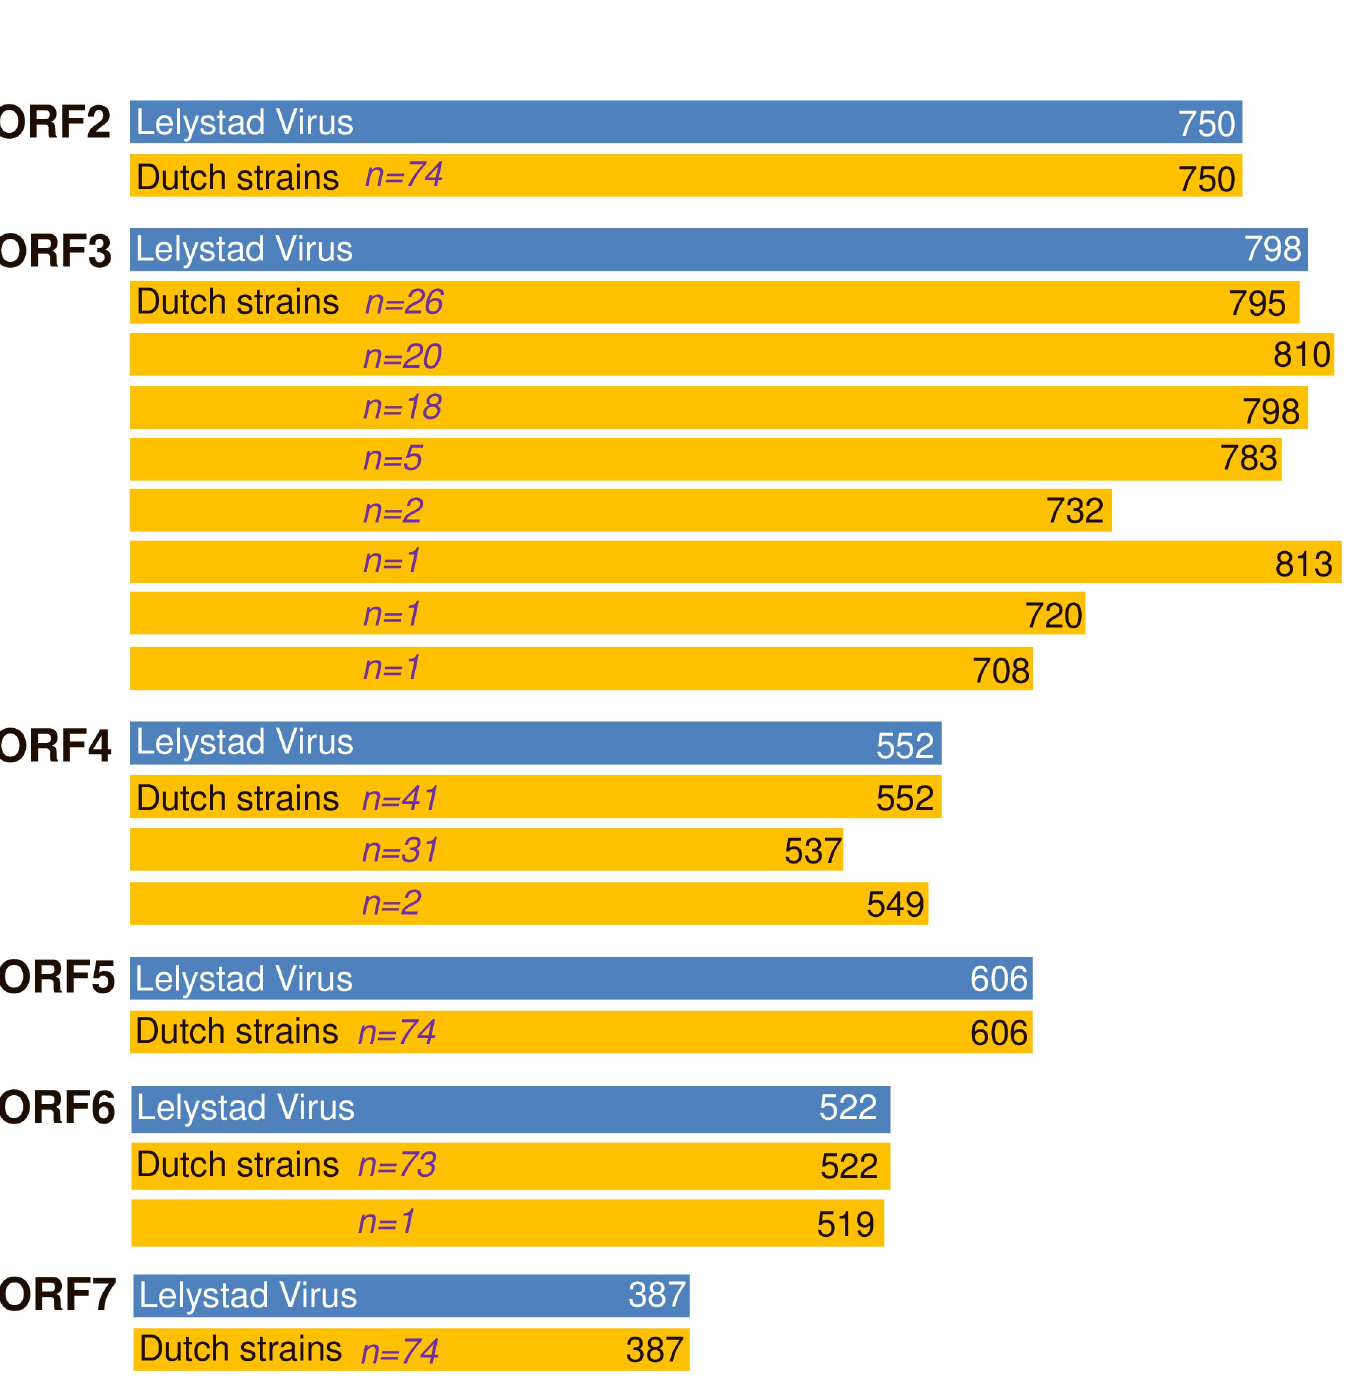
Fig 2. ORF length. Nucleotide length of the open reading frames (ORF) of the 74 isolates (orange) compared to the reference strain Lelystad Virus (GenBank M96262; blue).